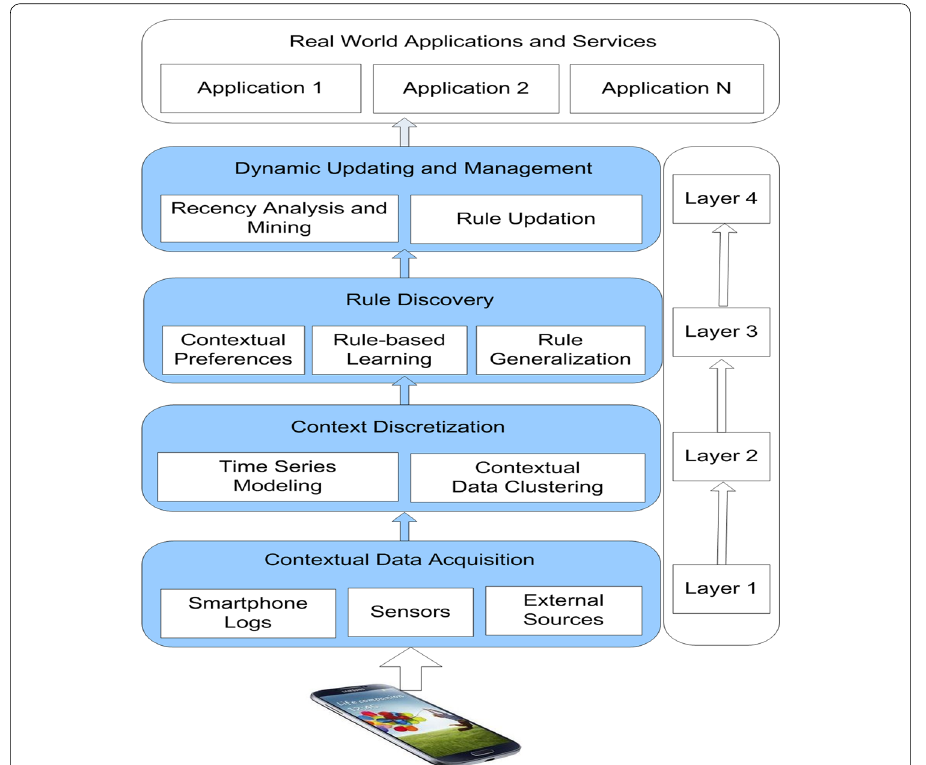
Fig. 2 An overview of the suggested machine learning based context-aware rule learning